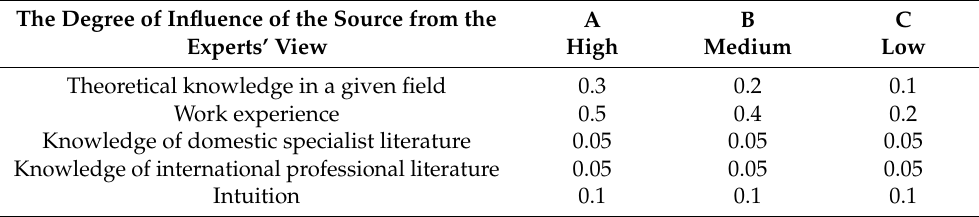
Table 1. Argument coefficient values used in the expert-mathematical